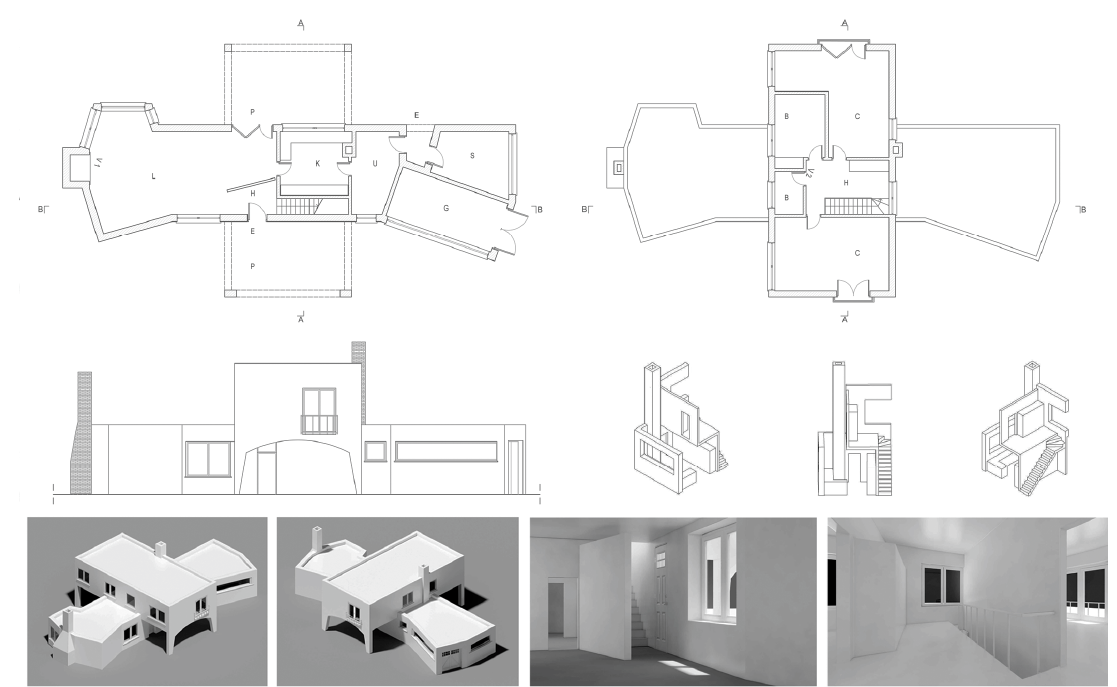
Figure 3. House 1. Plans, front, schemes, isometric views, perspectives (C. Gelardi).